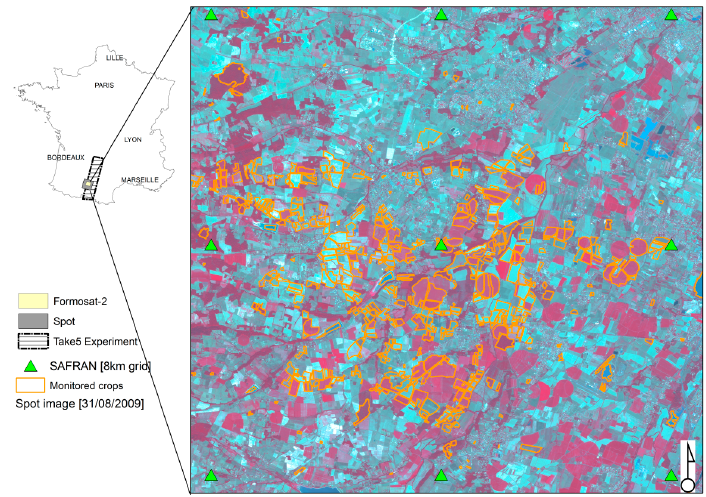
Figure 1. Study site location together with the monitored plots (in orange) and the meteorology points with SAFRAN grid (in green) on a color-composed Spot image.